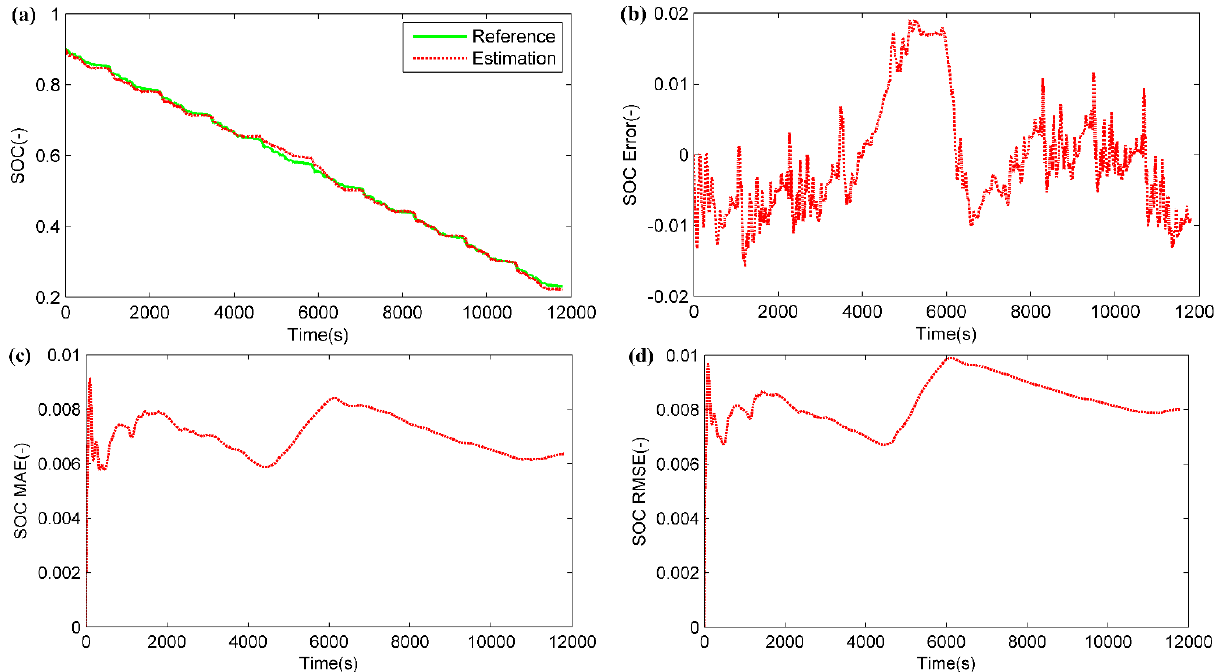
Figure 11. SOC estimation results with accurate initial SOC for LFP battery cell: ( a ) Comparative profiles of reference and estimated SOC; ( b ) Error of SOC estimation; ( c ) MAE of SOC estimation; ( d ) RMAE of SOC estimation.